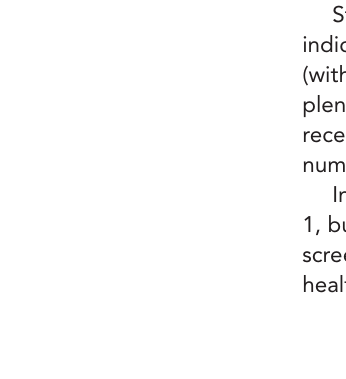
Figure 1 Flow diagram of the study and its participating health